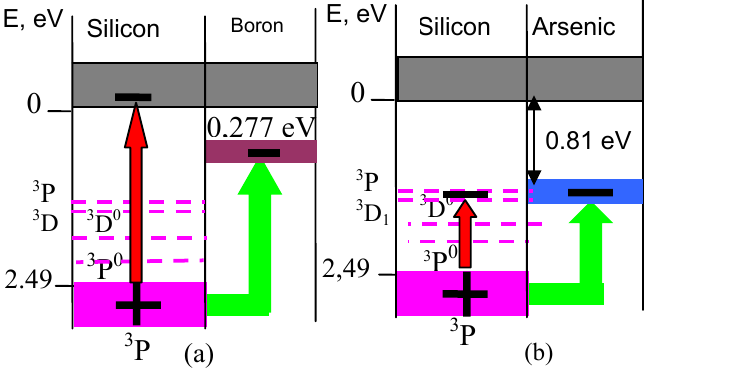
Figure 4 – Energy band diagrams of the formation of: (a) n- conductivity and (b) р -conductivity Рис . 4 – Энергетическая схема формирования : а ) n- проводимости и б ) р - проводимости Слика 4 – Енергетска шема формирања ( а ) н - проводљивости и ( б ) п -